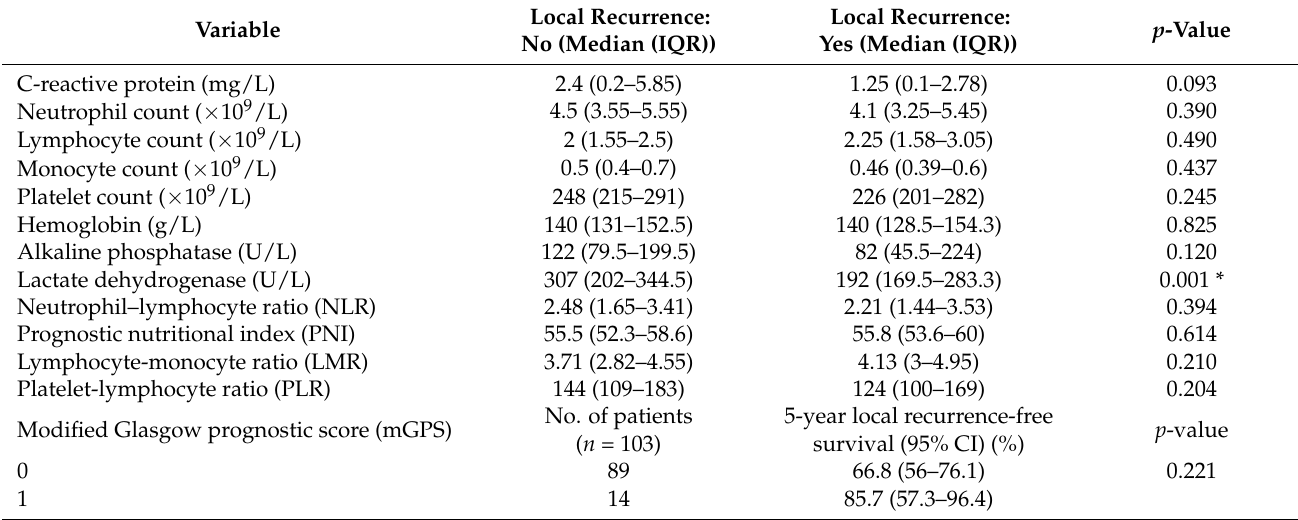
Table 4. Association between inflammatory markers and local recurrence.